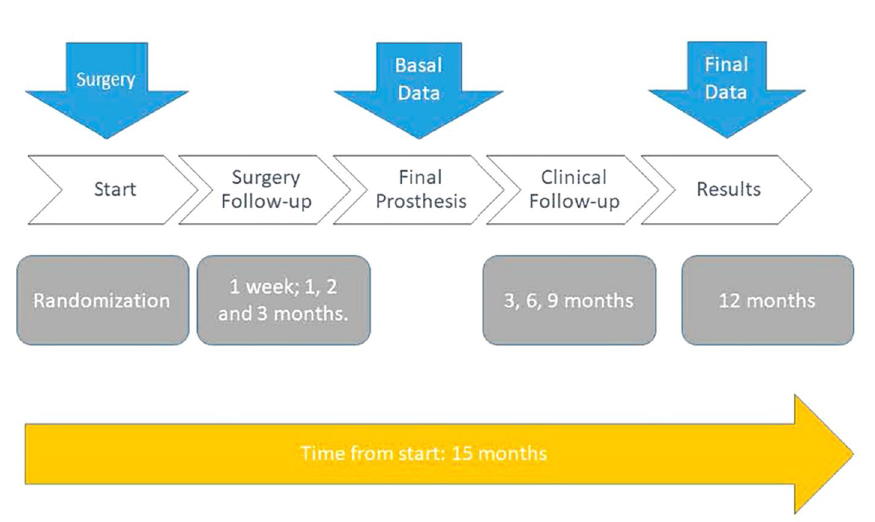
Figure 3. Scheme of the follow-up protocol for treated